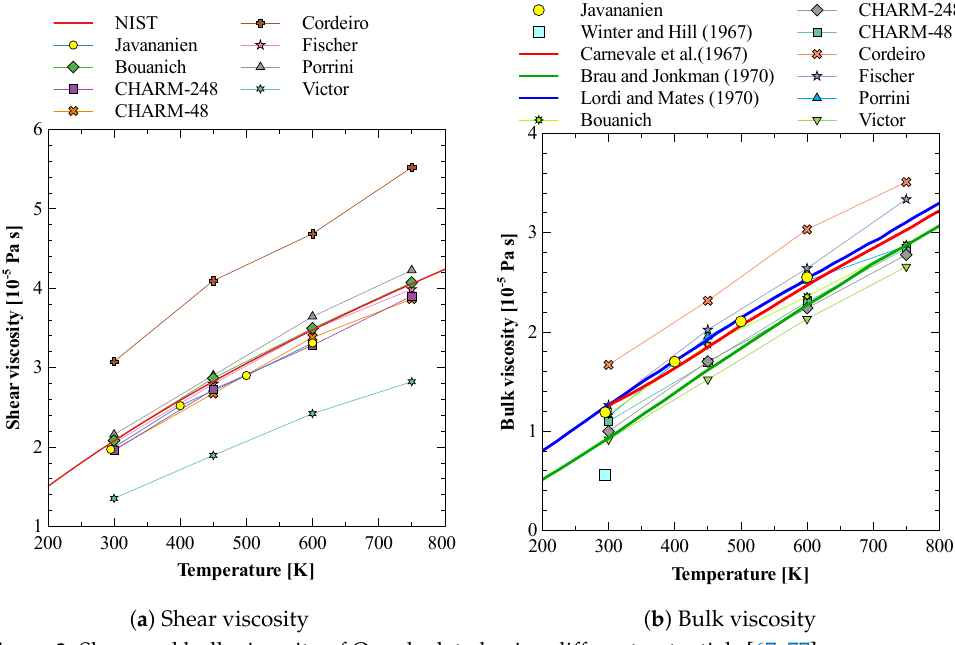
Figure 3. Shear and bulk viscosity of O 2 calculated using different potentials